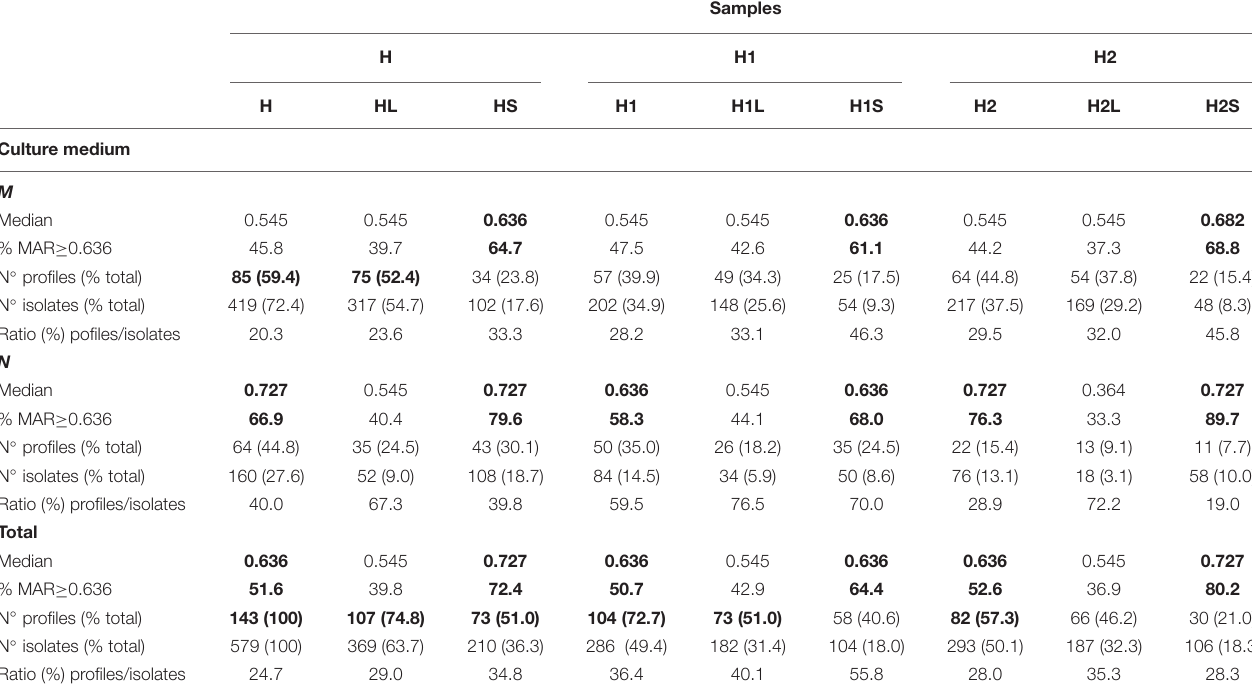
TABLE 1 | Characteristics and distribution of Ap R isolates among the samples tested on nutritive and marine media.